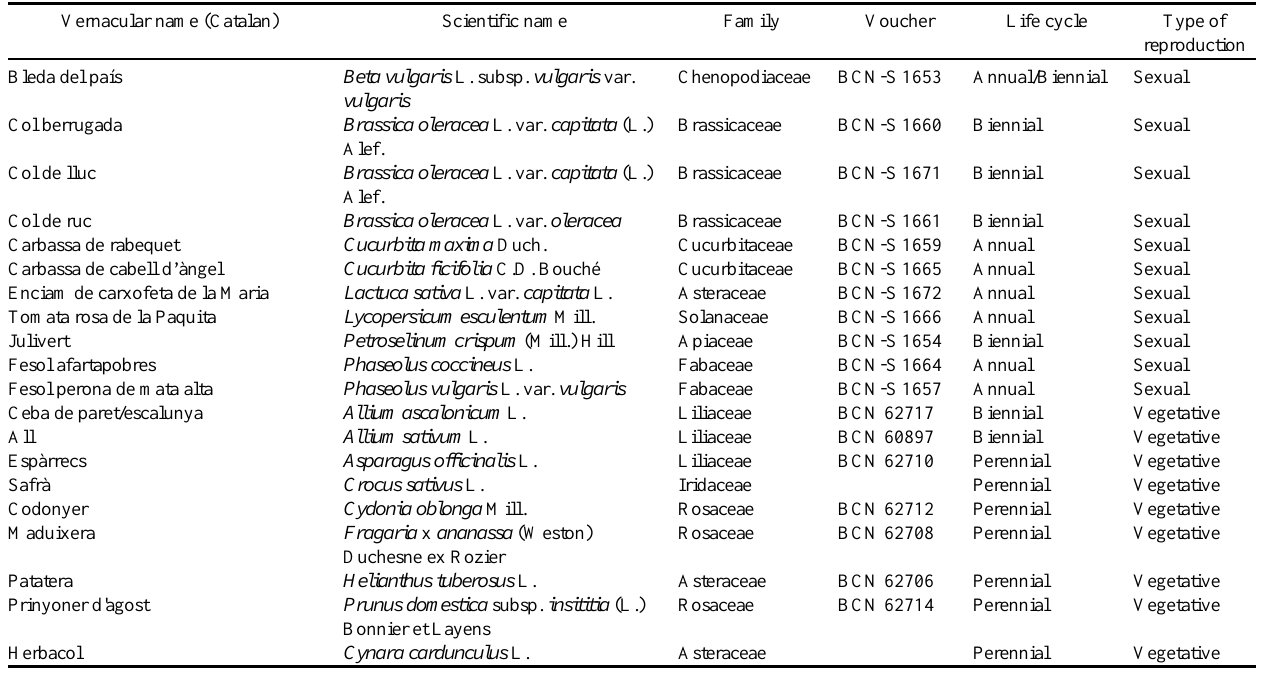
Table 1 . Local landraces in Vall Fosca home gardens. Type of reproduction refers to the main way that gardeners reproduce the local landraces in the